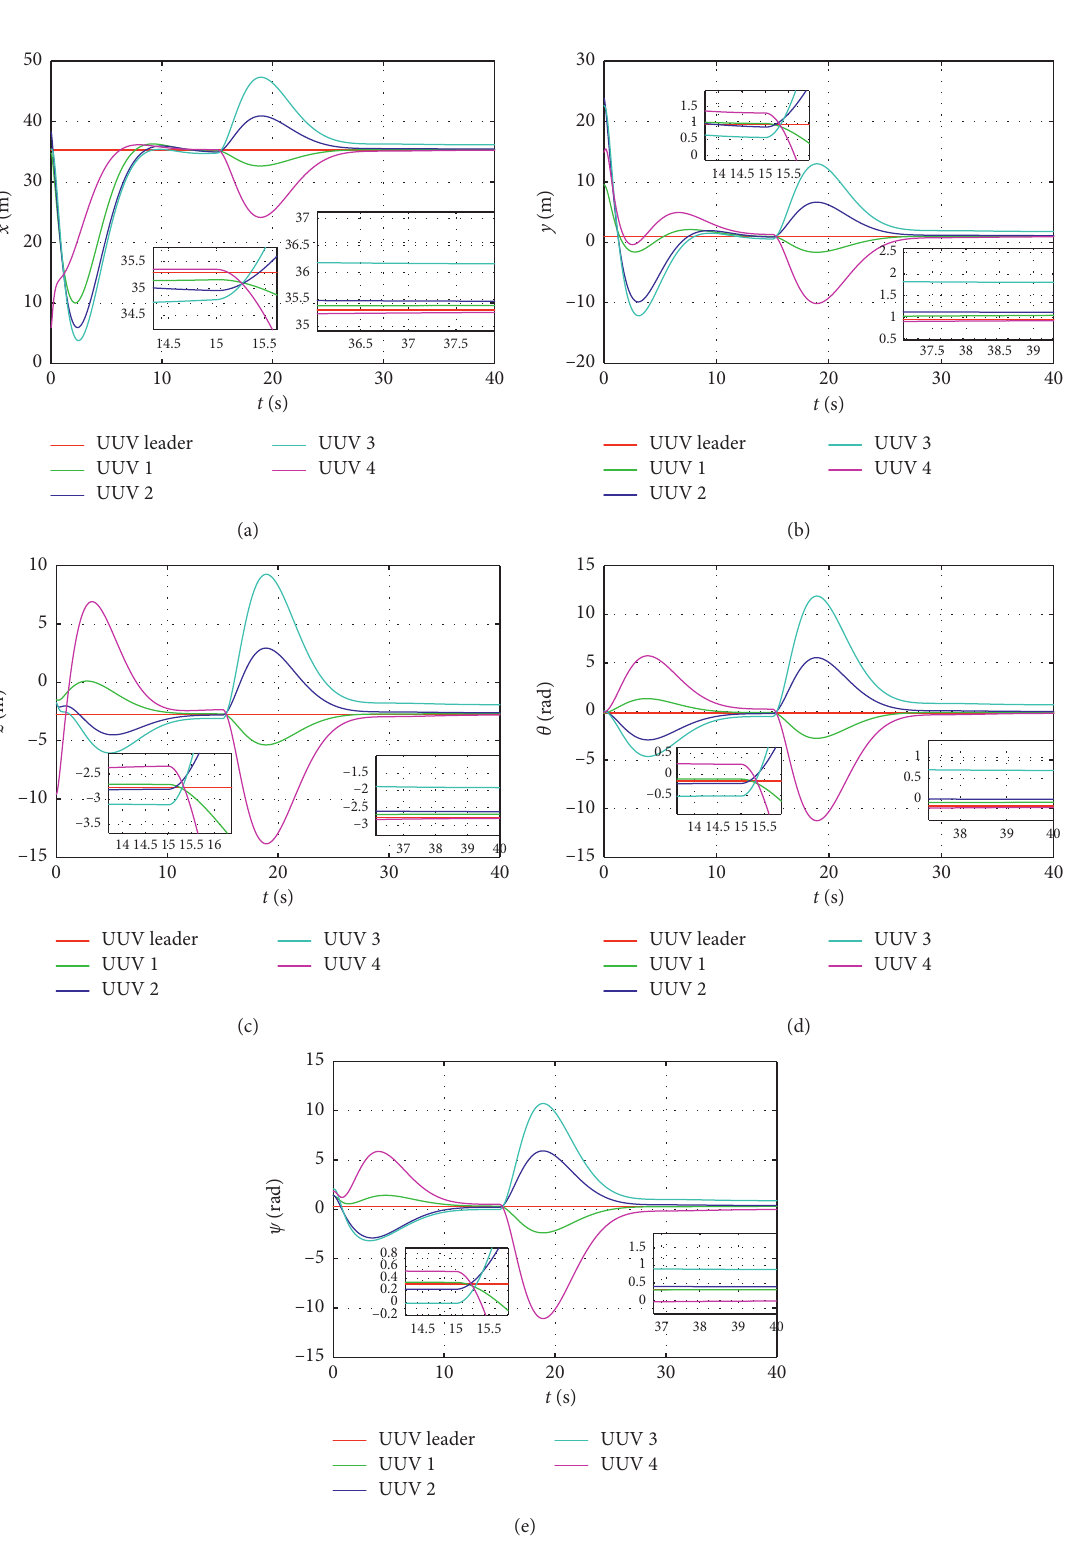
Figure 10: Position and attitude states of leader-following multi-UUVs with algorithm (101) obtains poor control performance with big chattering algorithm (74), the algorithm (101) cannot reach consensus in Figure 11. It is observed that the methods fail to reject the control for multi-UUVs with disturbances under the disturbances for multi-UUVs effectively. switching topology before 15 sec. Note the proposed method